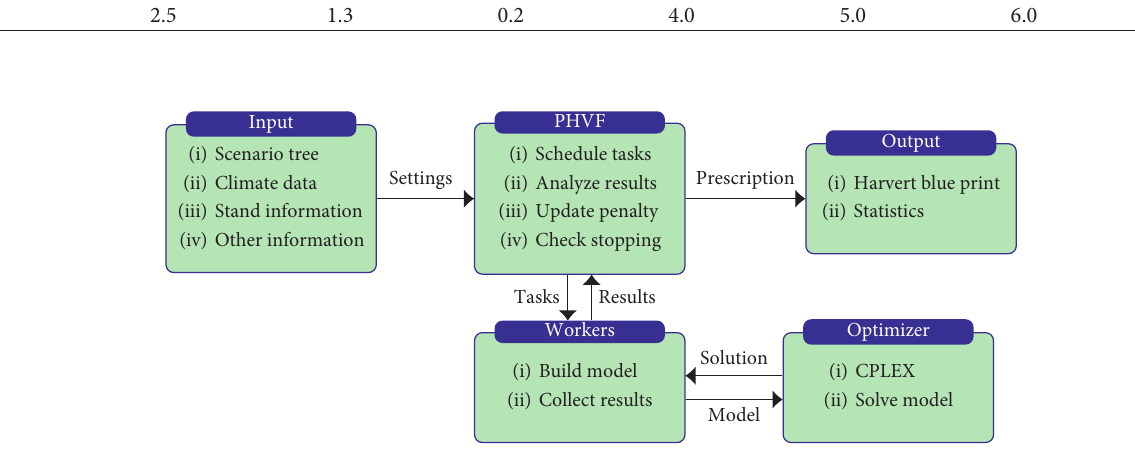
Figure 4: Framework of the PHVF algorithm for harvest scheduling under climate change.